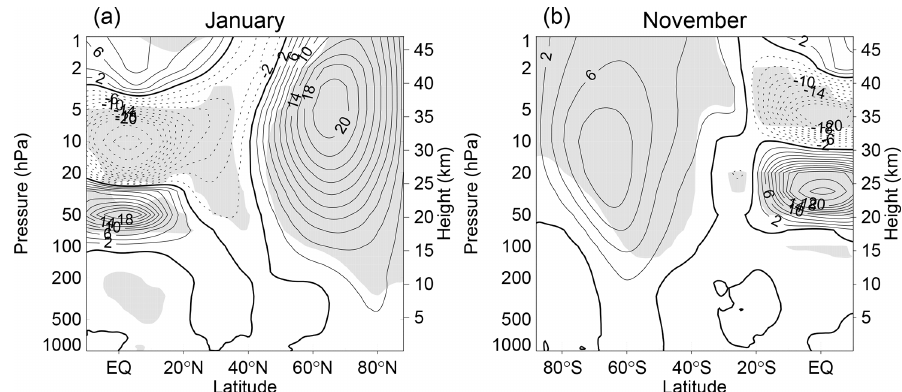
Figure 13. Holton–Tan effect for January in the NH and November in the SH. Latitude–height cross sections of the monthly and zonal mean zonal wind averaged over all years when the winds at the Equator are ≥ 2 . 5ms − 1 minus the average over all years when the winds at the Equator are ≤ − 2 . 5ms − 1 at 50 and 30hPa in January and November, respectively. The contour interval is 2ms − 1 for values between − 20 and + 20; otherwise, the interval is 10ms − 1 . Negative values are shown by dotted contours, and shading indicates where the differences are statistically significant at the 95% level according to Student’s t test. Based on the same ERA5.1 reanalysis data (Hersbach et al., 2020) for 1979–2020 as used in Fig.